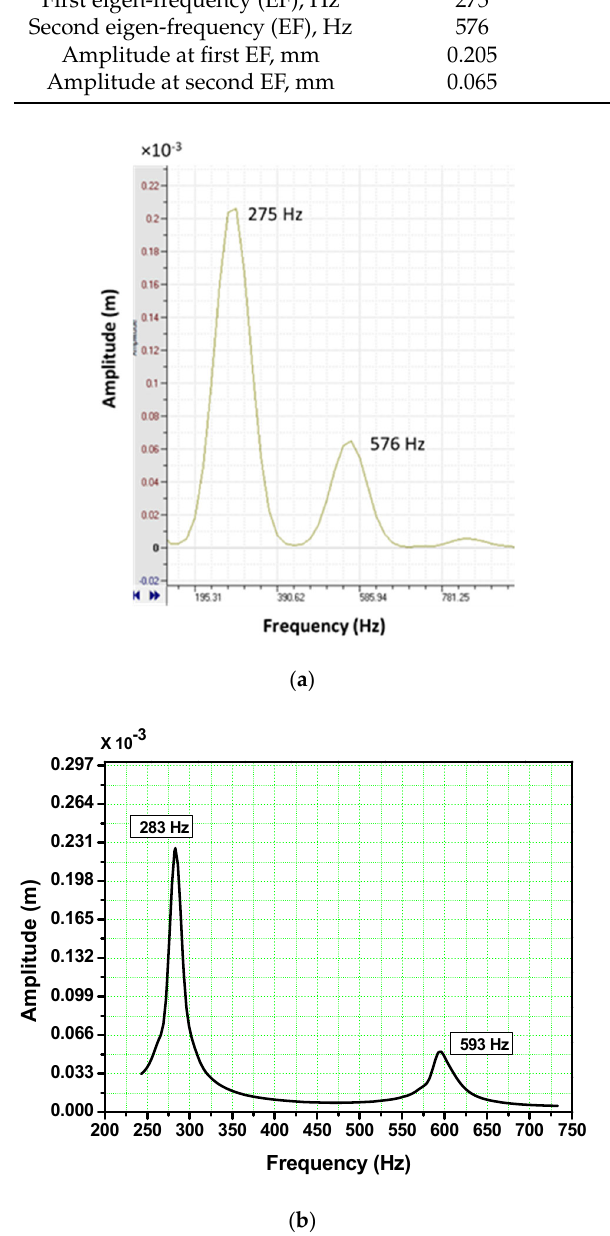
Figure 5. Amplitude and eigen values ( a ) experimental and ( b ) numerical simulations.